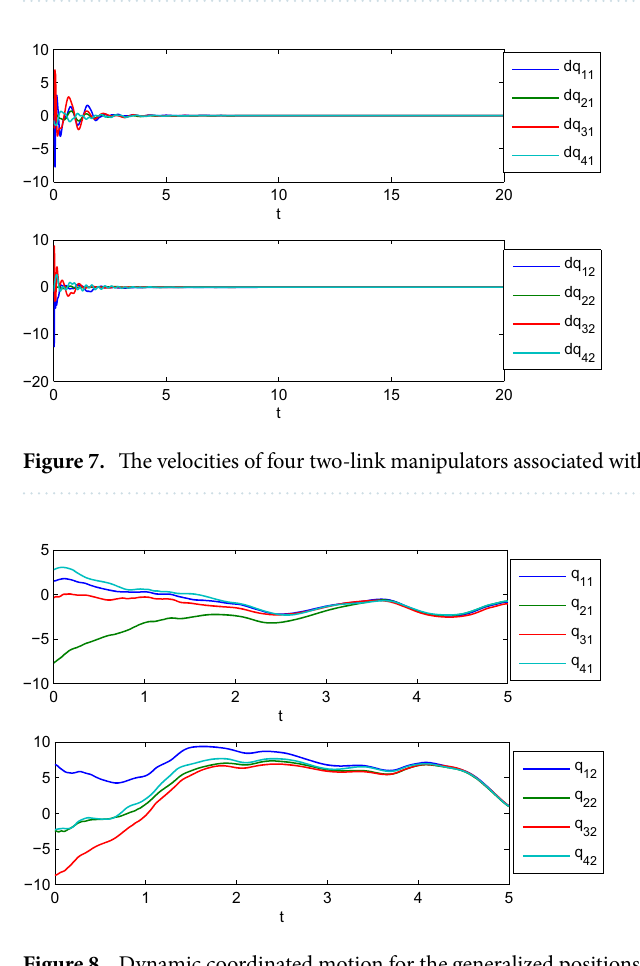
Figure 6. Cluster consensus progress for the generalized positions of four two-link manipulators.